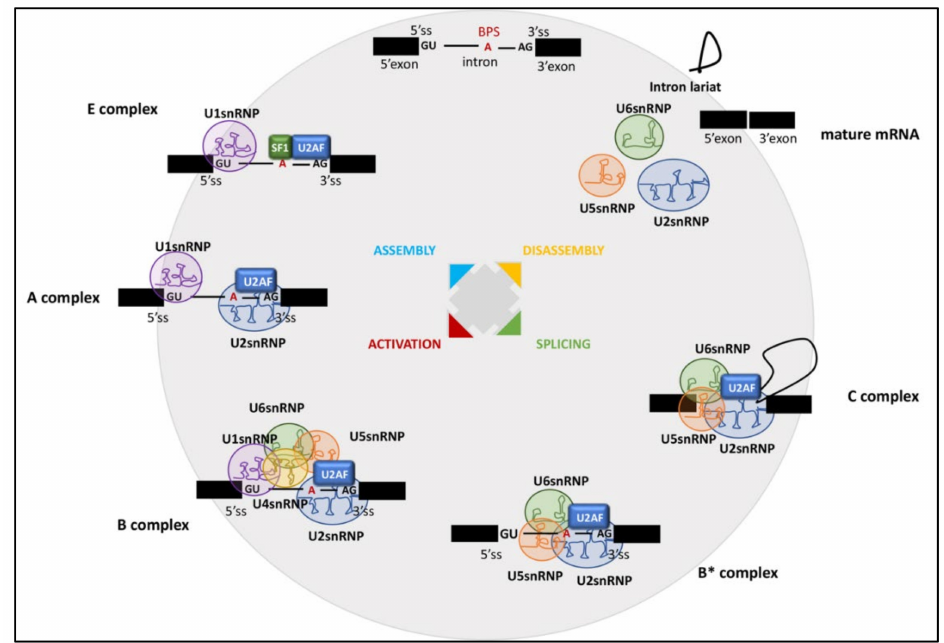
Figure 1. Pre-mRNA assembly by the spliceosome machine. The stepwise interaction of the spliceo- somal snRNPs and RBPs in the removal of an intron from a pre-mRNA containing two exons